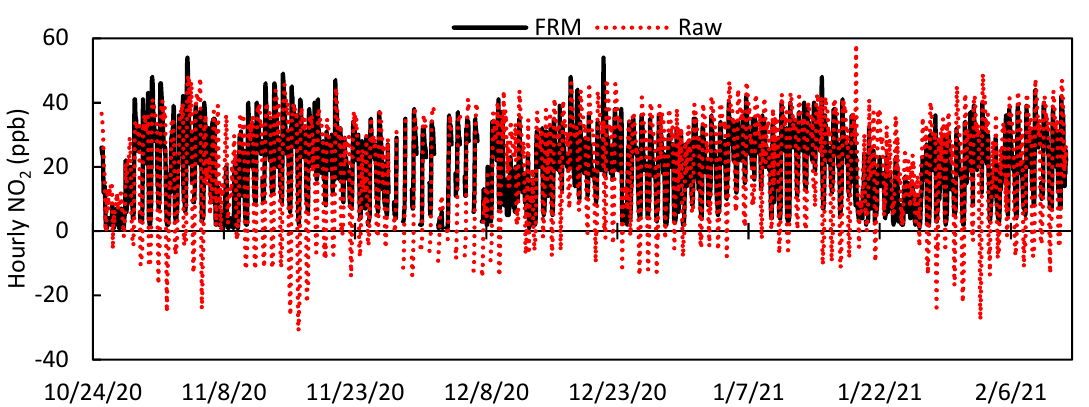
Figure 3 . Time series of hourly West Phoenix FRM NO 2 and LCS #2 Raw NO 2 values for the entire deployment period.